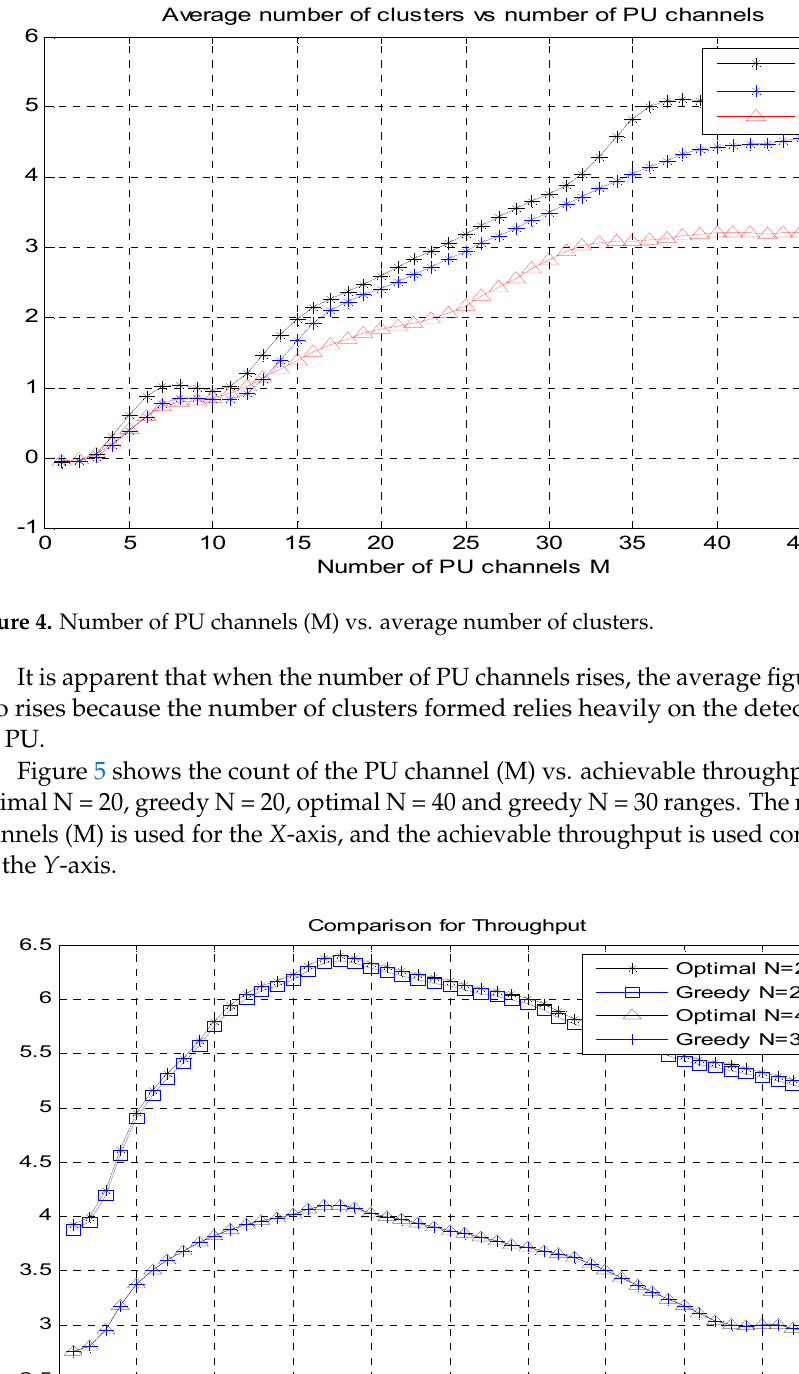
Figure 3. Number of sensed PU channels (M) vs. achievable throughput .